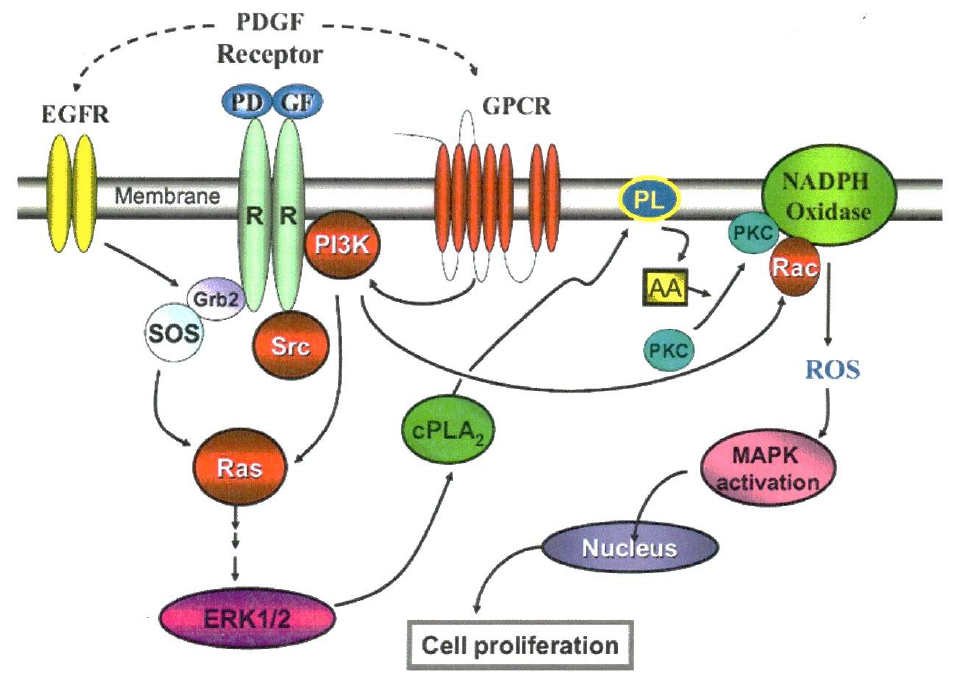
Figure 10. The proposed mechanism of PDGF signaling in the lens epithelial cells. The solid line indicates the known or published pathway and the dashed line represents proposed new pathway. In the figure, EGF denotes Epidermal growth factor, GPCR indicates G protein coupled receptor, PI3K indicates Phosphatidyl inositol-3-kinase, cPLA 2 denotes Cytosolic phospholipase 2, PL indicates Phospholipid, AA denotes Arachidonic acid, PKC indicates Protein kinase C, and ROS denotes Reactive oxygen species. Reprinted with permission from Chen et al., Molecular Vision (2007); Free Access [91].